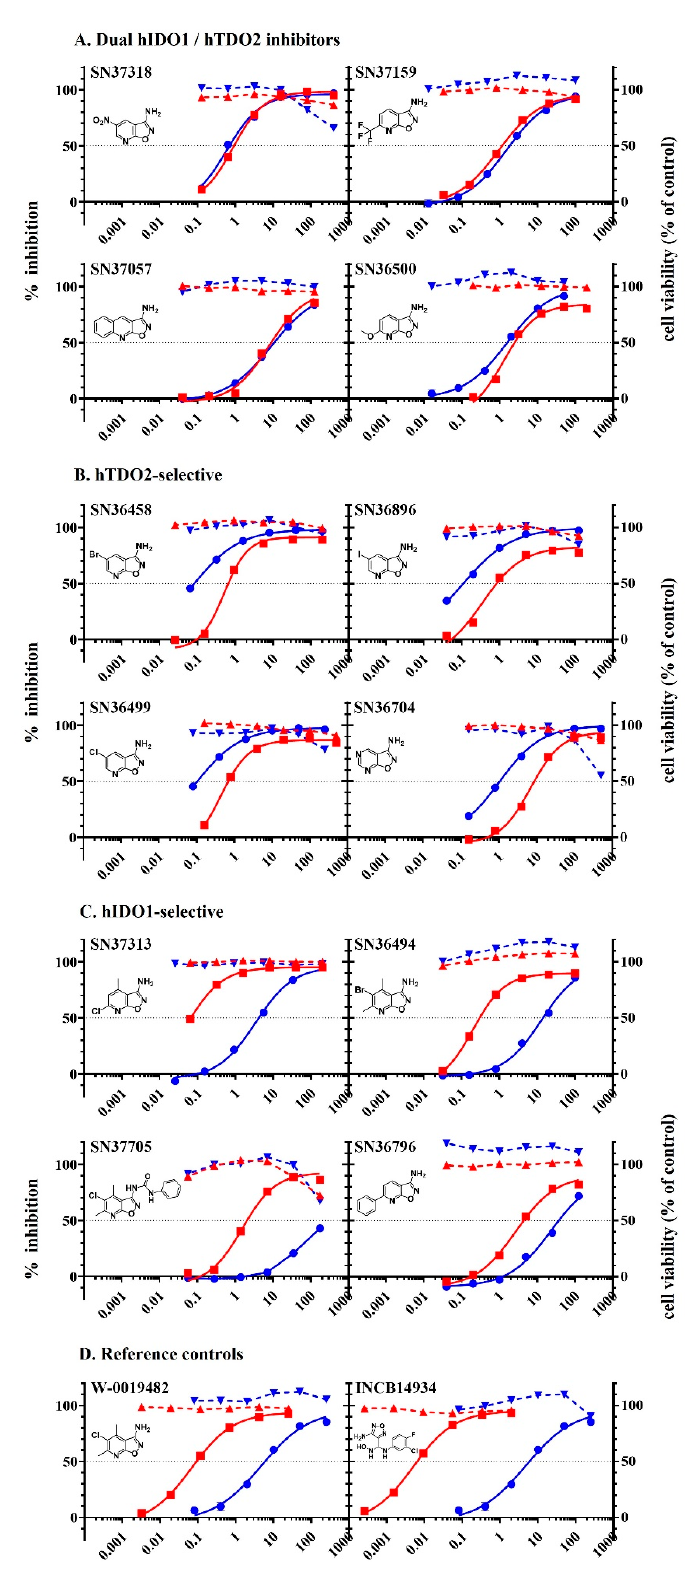
Figure 6. Percent inhibition of hIDO1 (red square) and hTDO2 (blue circle) activity and cell viability (% of control) of LLTC-hIDO1 (red triangle) and GL261-hTDO2 (blue triangle) in cell-based assays versus concentration of inhibitor for (A) Dual IDO1/TDO2 inhibitors; (B) hTDO2 selective; (C) hIDO1 selective; and (D) Reference controls W-0019482 and INCB14934.